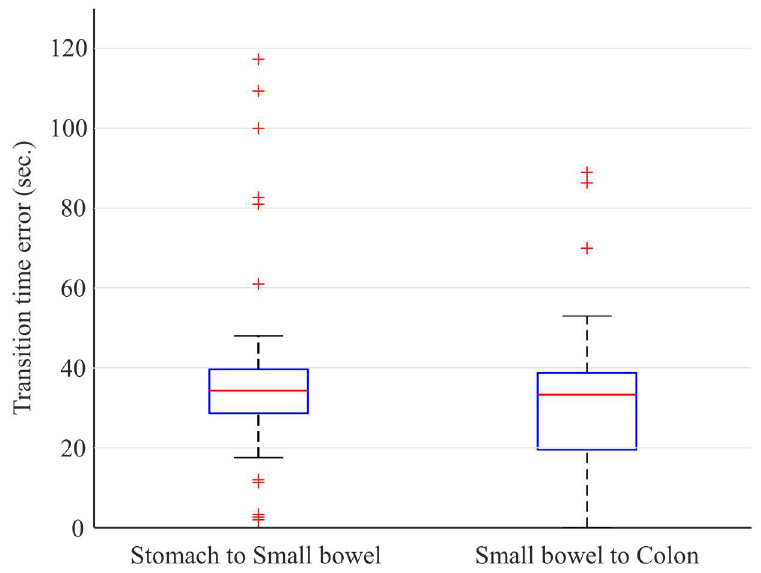
Figure 5. Time errors for the transition between stomach and small bowel and the transition between small bowel and colon. For all 40 test cases including 20 normal and 20 abnormal cases, all errors were less than 120 s.